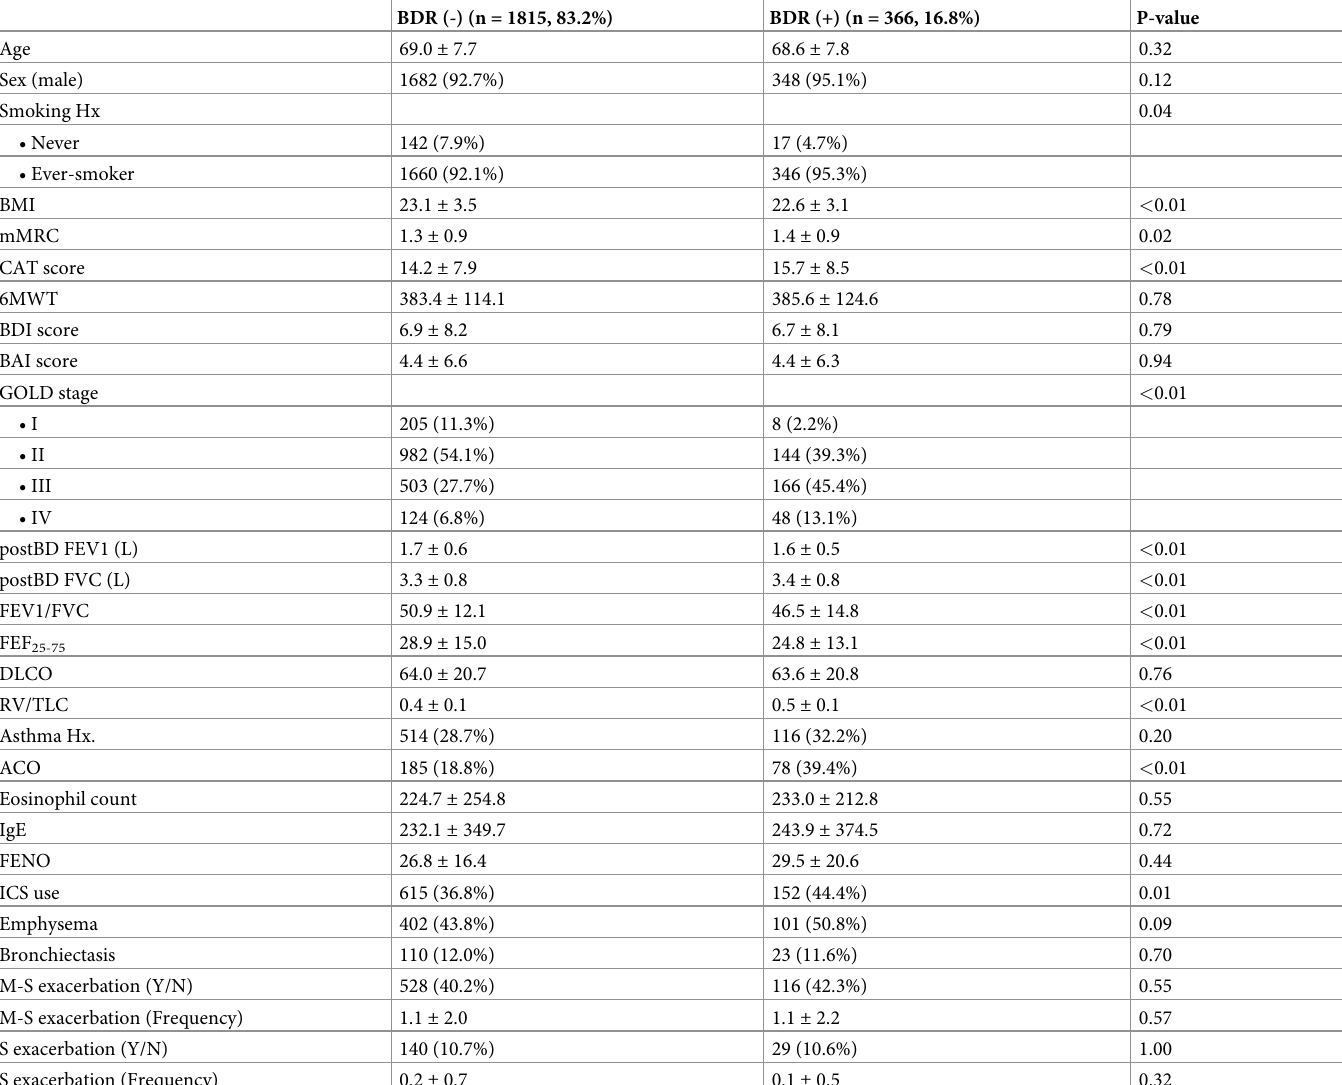
Table 1. Difference of clinical characteristics according to bronchodilator